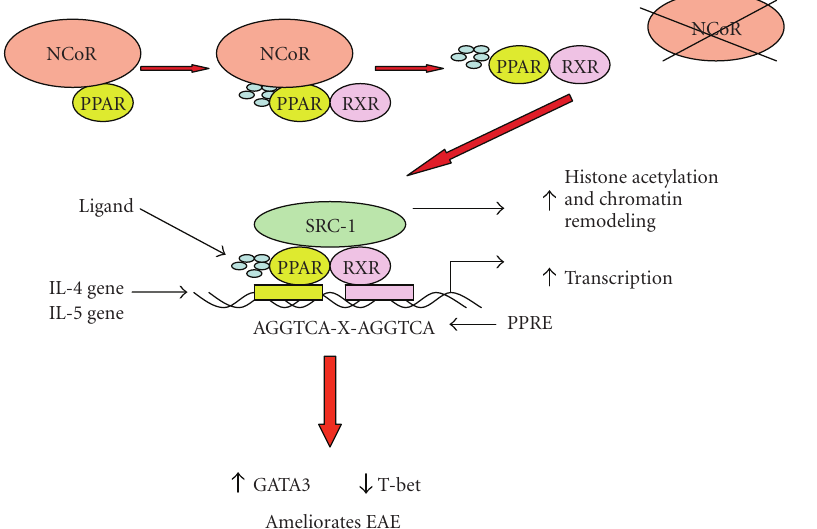
Figure 1: A model for PPAR- α -mediated protection in EAE . In the presence of PPAR- α agonists, PPAR- α heterodimerizes with RXR, dissociates from its nuclear corepressor complex, associates with a coactivator complex, and binds to PPREs in the promoter region of IL-4 and/or IL-5. The transactivation of IL-4/IL-5 leads to increased expression of GATA-3 which in turn results in decreased T-bet expression and downregulation of the Th1/Th17 inflammatory response. This shift in the immune response to a Th2-like phenotype results in amelioration of